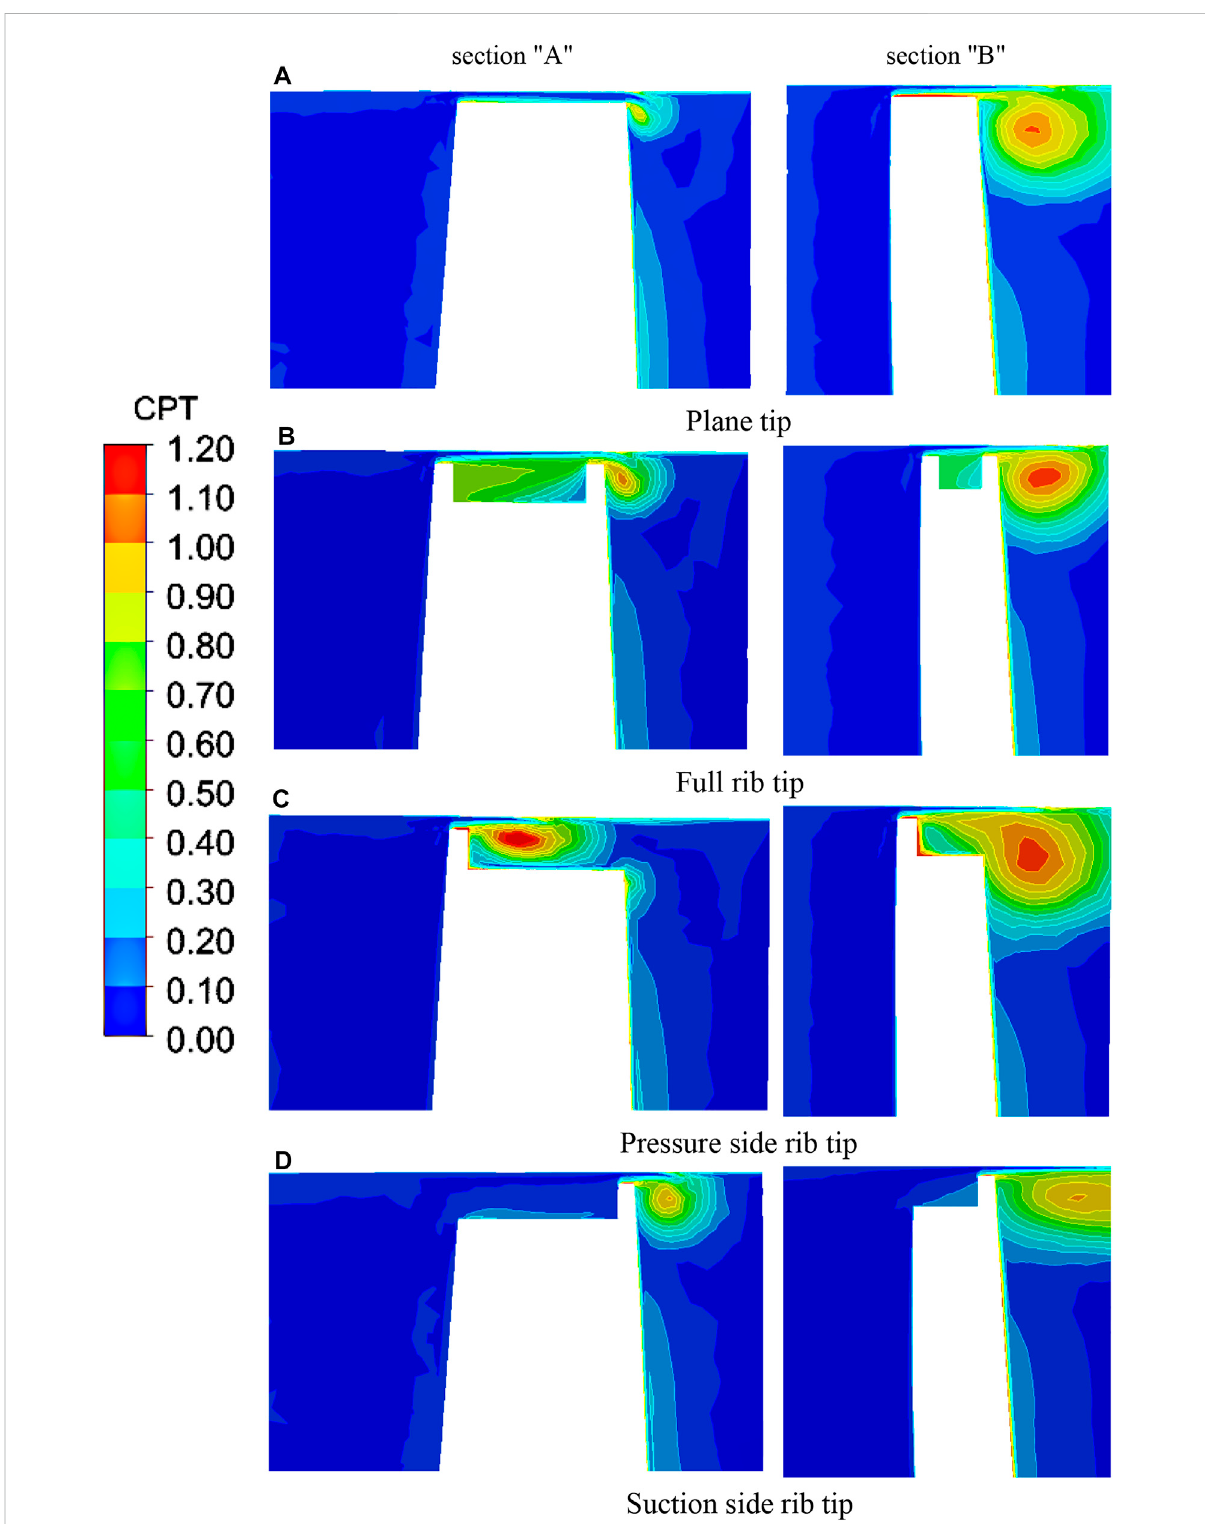
FIGURE 8 Total pressure loss distribution cloud diagram of section “ A" and section “ B". (A) Plane tip. (B) Full rib tip., (C) Pressure-side rib tip. (D) Suction- side rib